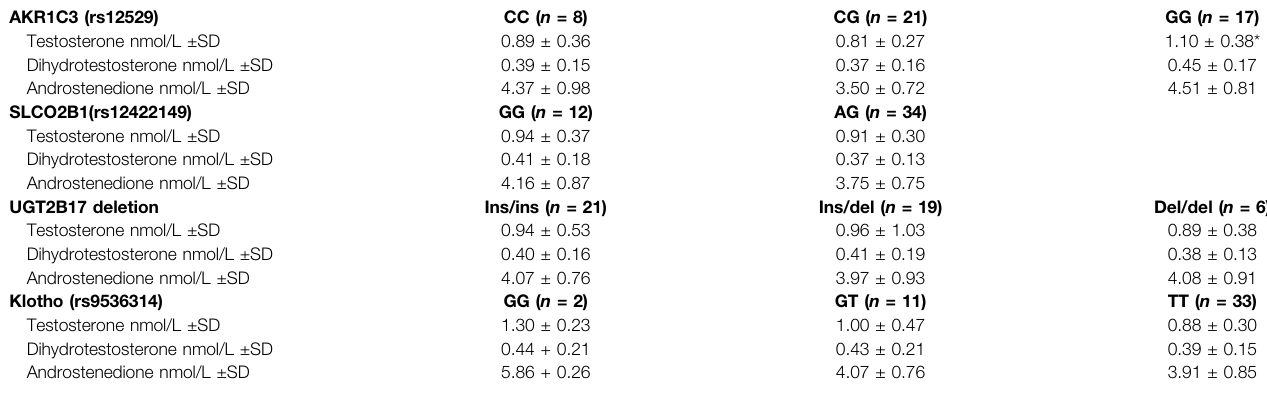
TABLE 2 | Distribution of polymorphisms in steroidogenic genes and androgen serum concentrations prior to intervention (at baseline) in the combined groups of women in the testosterone group and the placebo group (mean ± SD). Samples were taken in the follicular phase of the menstrual cycle ( n = 44 women). AKR1C3